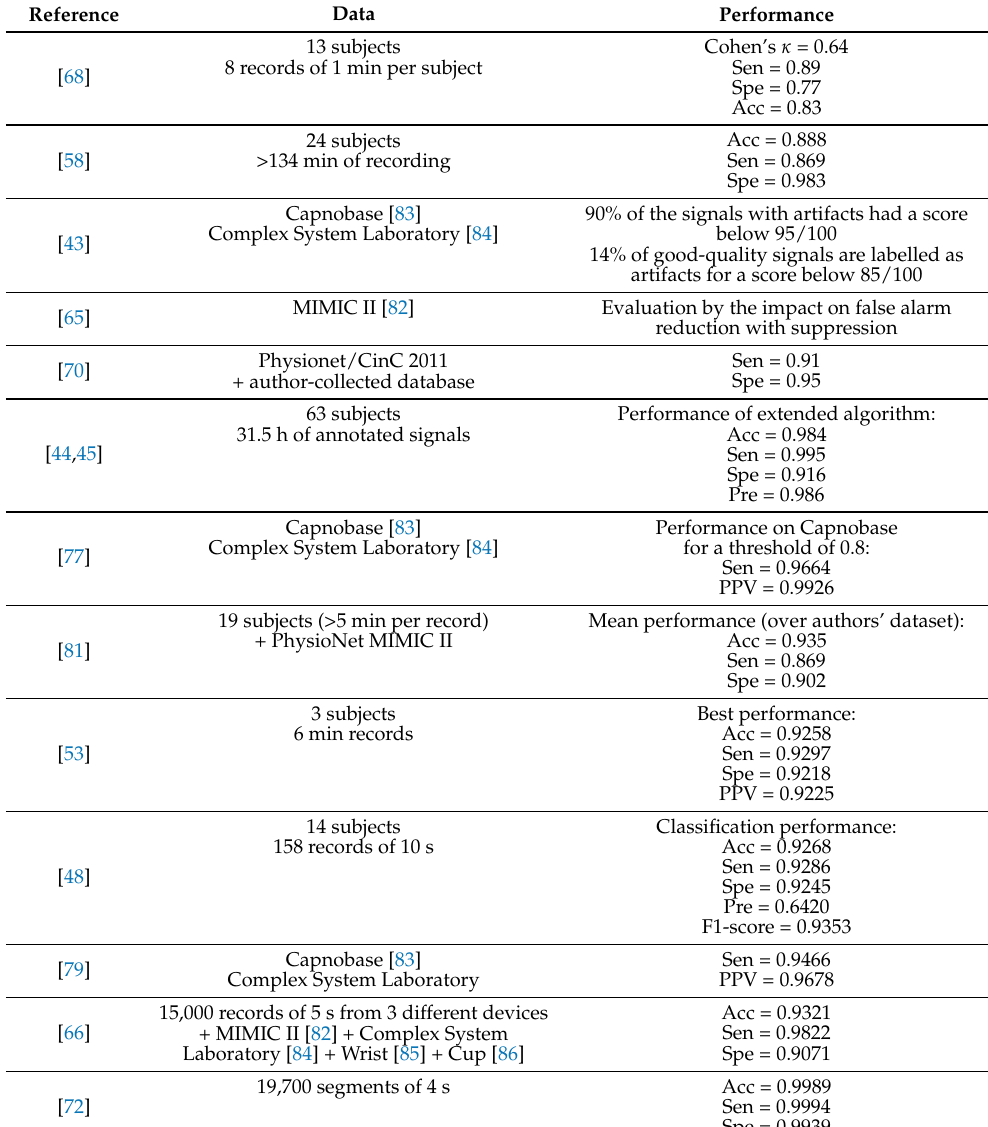
Table 5. Summary of the rule-based type of quality assessment